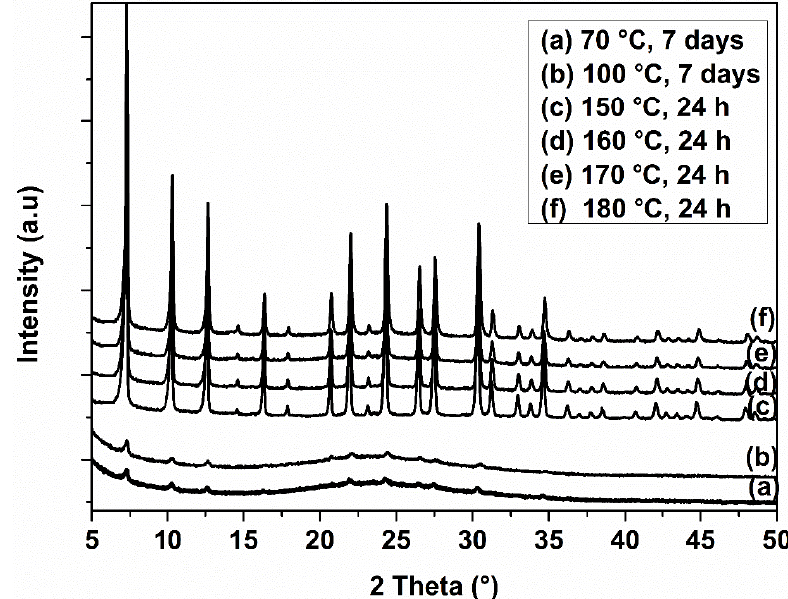
Figure 1. XRD patterns of ZK-4 microspheres synthesized at different temperatures and treatment times.